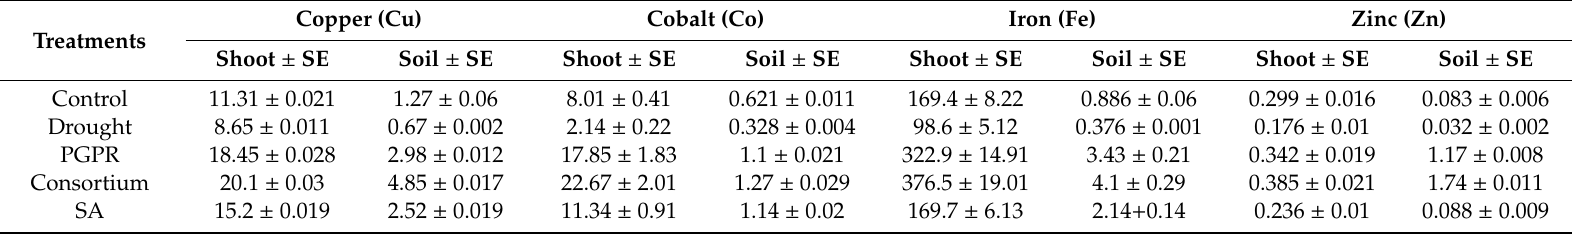
± SE-represents standard error